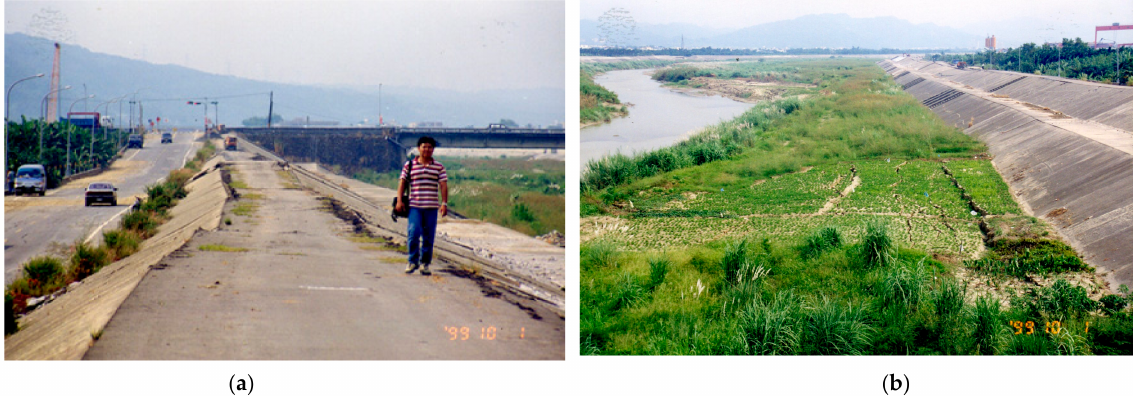
Figure 12. Damage of the demonstration site after 1999 Chi-Chi Earthquake, ( a ) settlement of the embankment, ( b ) lateral spread of